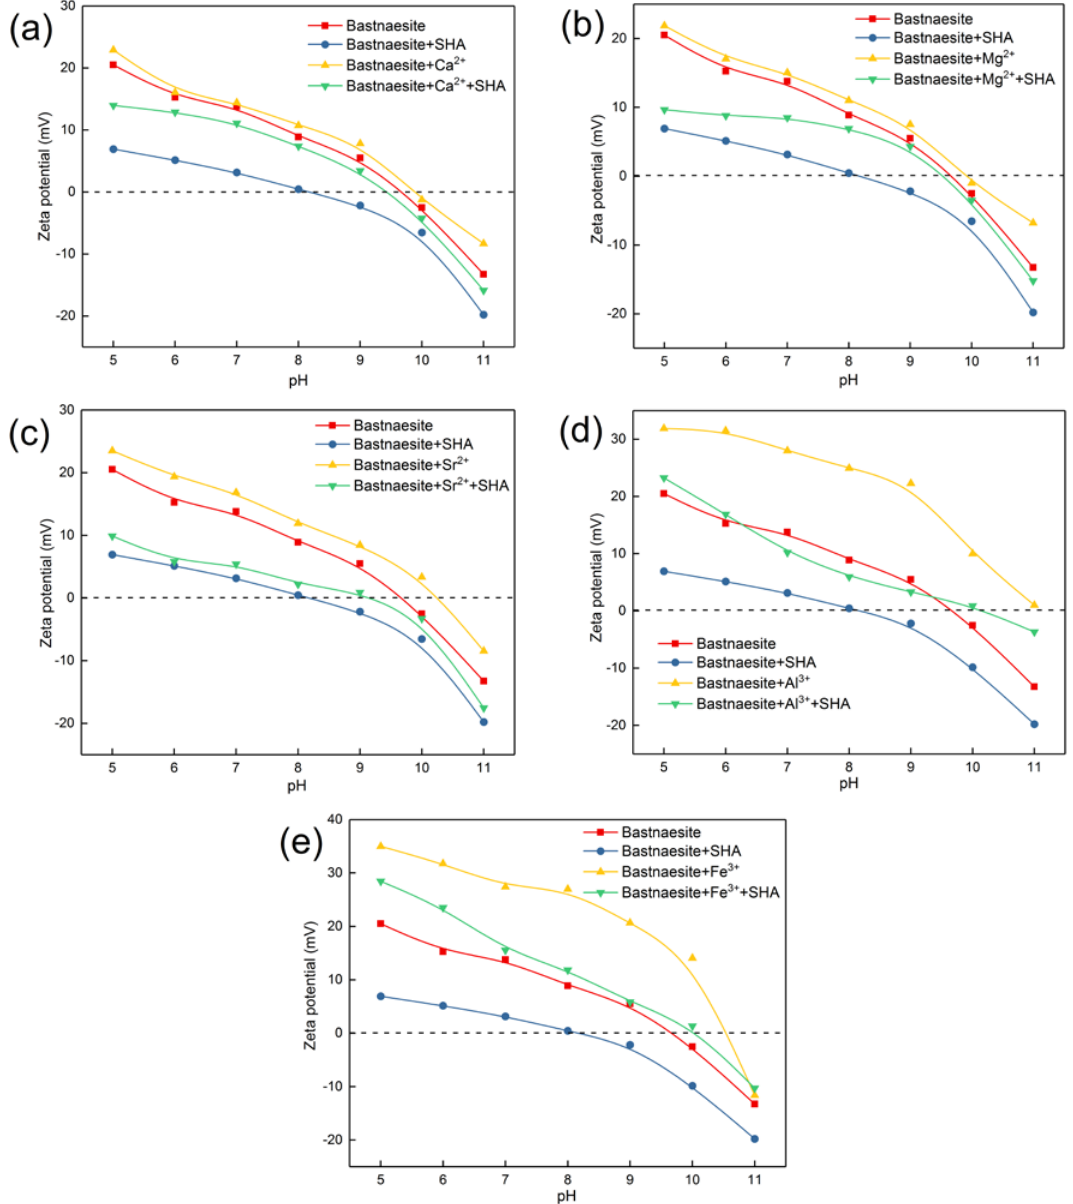
Figure 9. Zeta potential of bastnaesite treated and not treated with ( a ) Ca 2+ ; ( b ) Mg 2+ ; ( c ) Sr 2+ ; ( d ) Al 3+ ; ( e ) Fe 3+ as a function of pH in the absence and presence of pH.